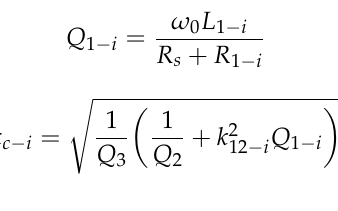
Figure 4. Circuit model of the proposed three-coil IPT system.